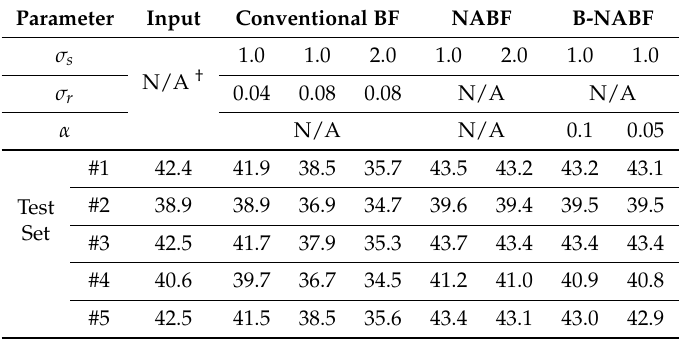
Table 2. Average PSNR with Scene